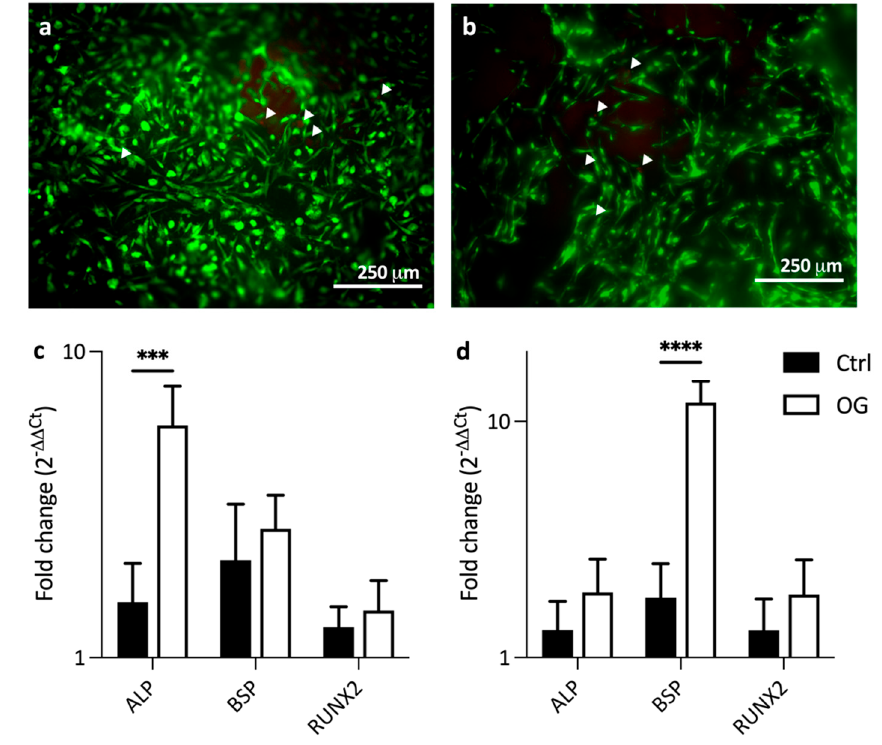
Figure 6. Live/dead staining of bmMSCs cultured on scaffolds for 14 days in ( a ) control and ( b ) osteogenic media demonstrating good cell adhesion and viability. Arrowheads indicate dead cells (stained red). The qRT-PCR analysis of bmMSCs cultured on scaffolds for ( c ) 4 and ( d ) 14 days in either control (Ctrl, black) or osteogenic (OG, white) media shows increased gene expression of ALP, BSP, and RUNX2 in osteogenic media at both time points. Data presented as mean ± SD, n = 3 *** = P < 0.0005, **** = P < 0.0001.